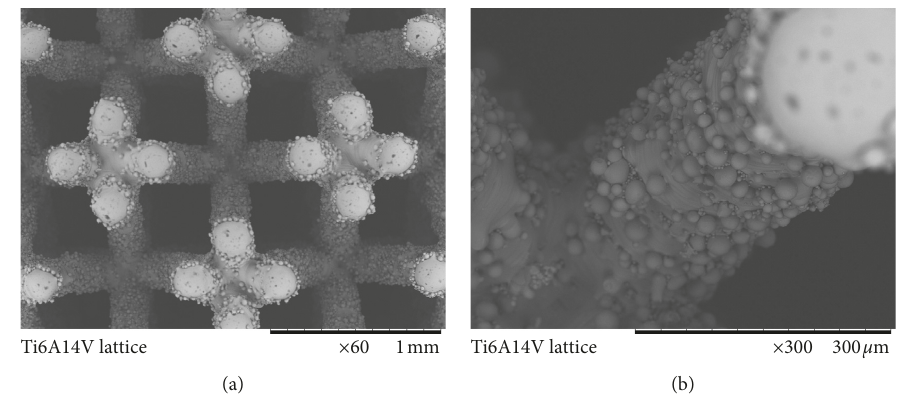
Figure 3: SEM micrographs of 3D printed Ti6Al4V